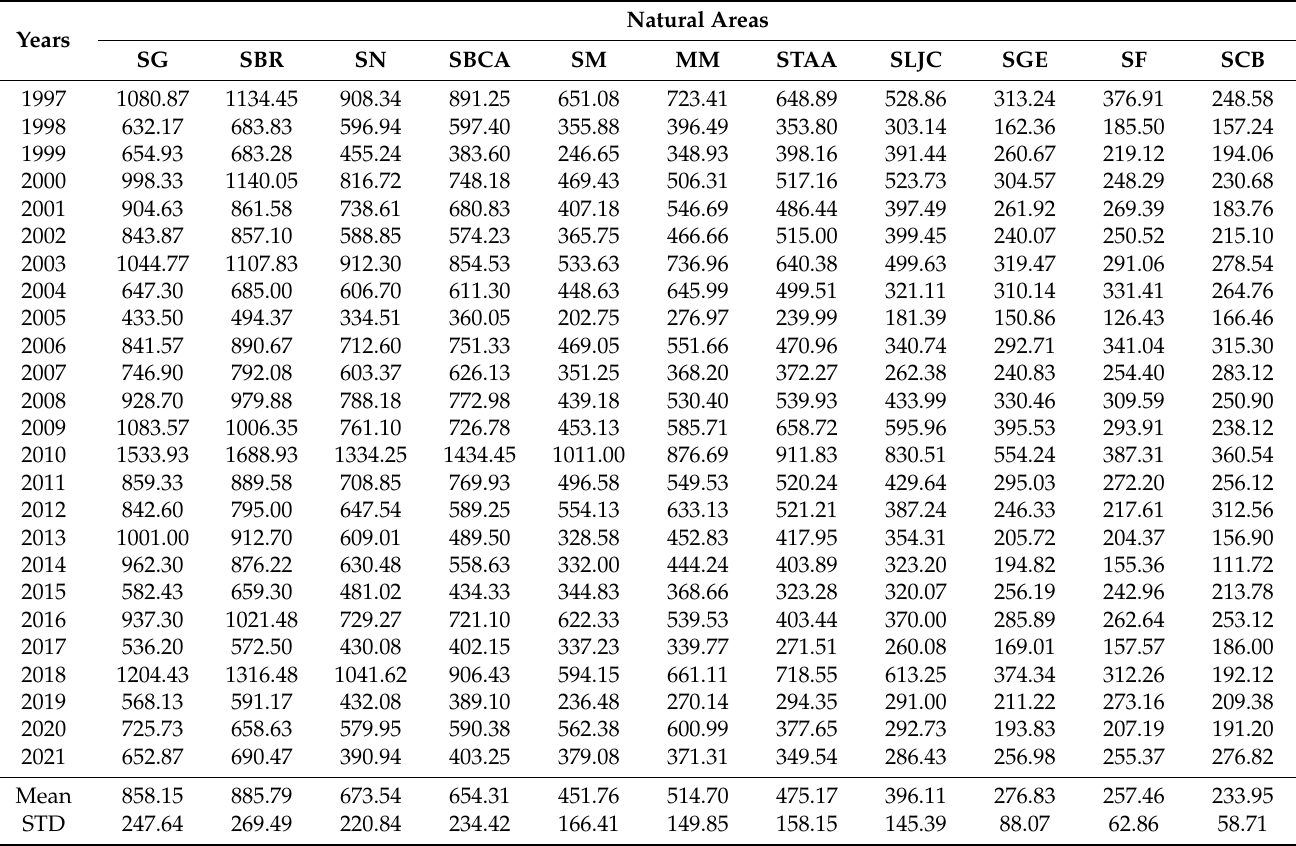
Table 3. Annual distribution of precipitation (L/m 2 ) for each natural